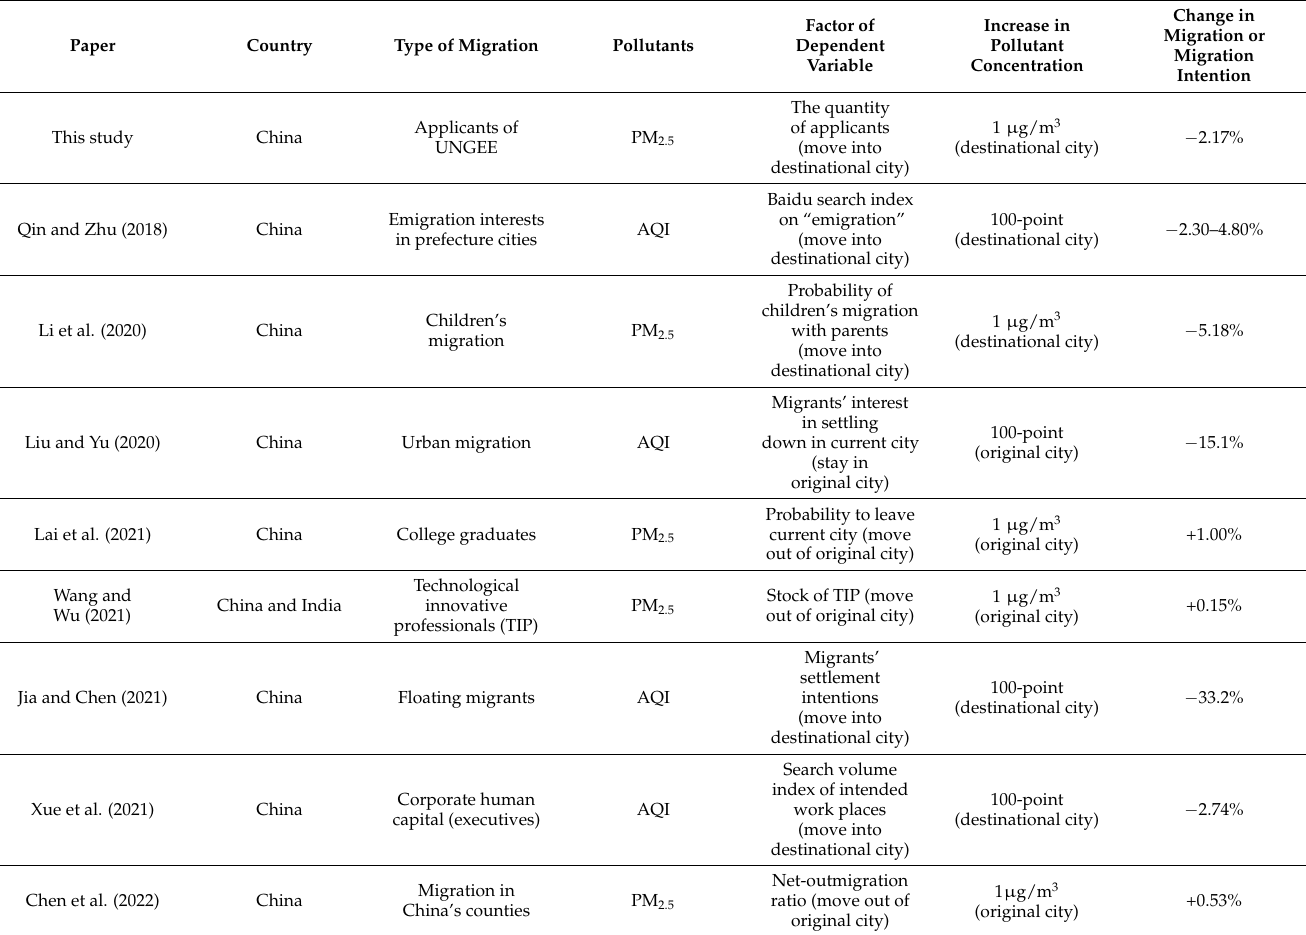
Table 7. Summary of the estimated air pollution impacts on migration or migration intention in existing